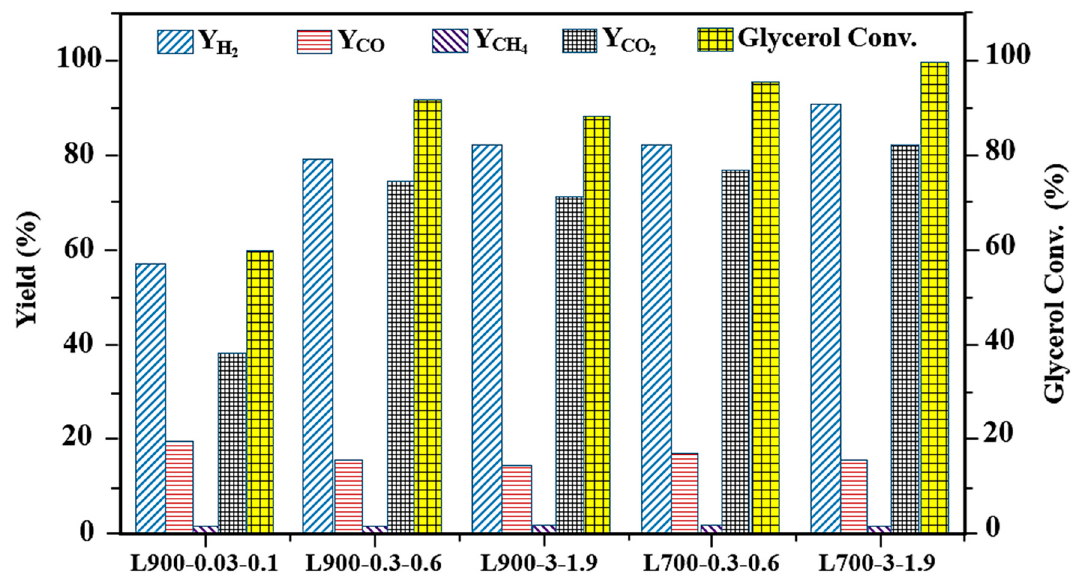
Figure 10. The glycerol conversion and yield for the gaseous products in SR of the glycerol over LT-X-Y perovskite-type mixed oxides (575 ◦ C, H 2 O / C 3 H 8 O 3 molar ratio of 15, and 49.7 g h / mol) [93] (redrawn with copyright permission). Table 9. Catalytic performance for SR of glycerol [94] (used with copyright permission). T ( ◦ C) Catalyst Glycerol Conversion (%) Selectivity (%) H 2 CO 550